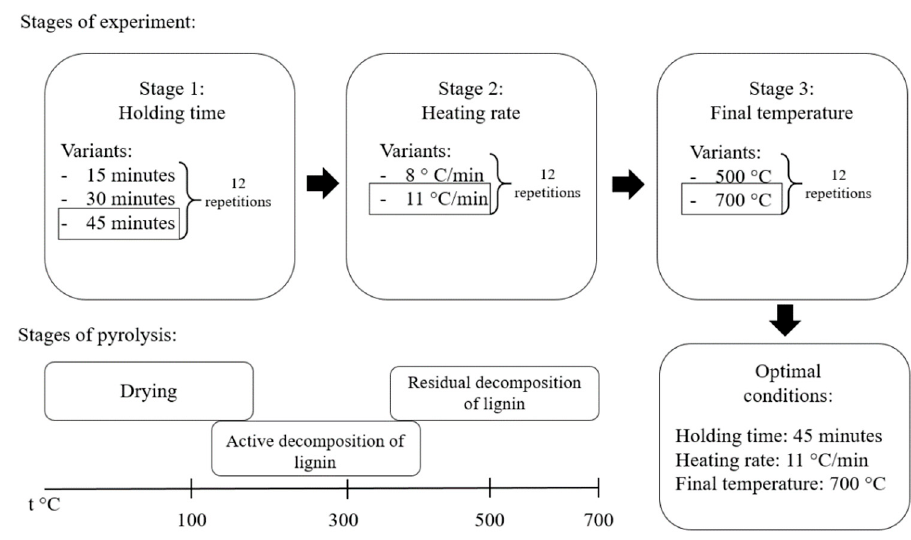
Figure 1. Scheme of experiment.